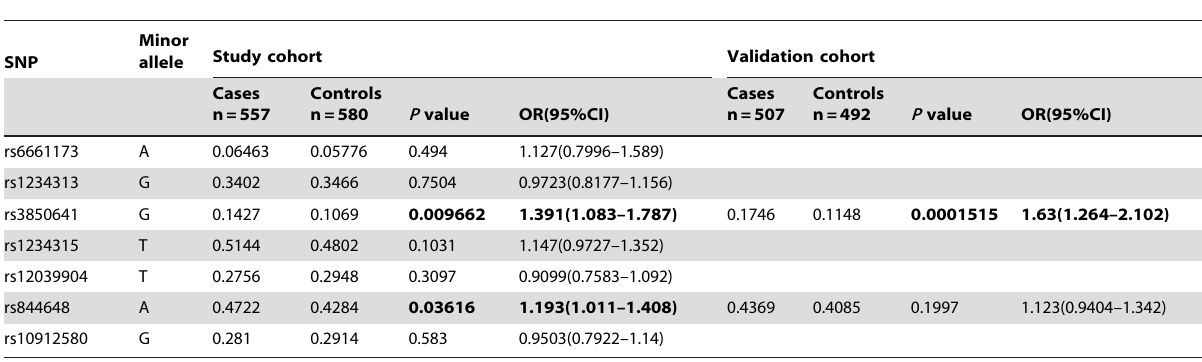
Table 2. Alleles of the seven SNPs of OX40L gene between cases and controls.